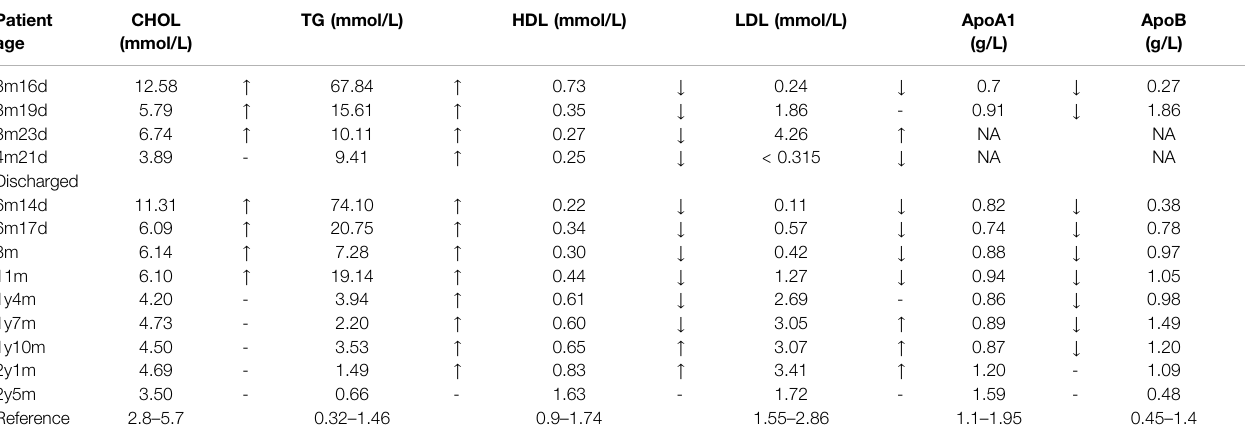
TABLE 1 | Biochemical examinations of blood lipid and lipoprotein